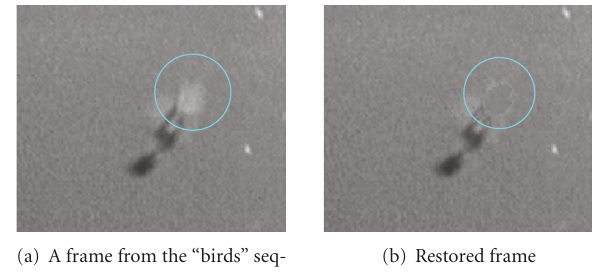
Figure 18: This figure shows an example from the “birds” sequence where the proposed algorithm fails to prevent damage to image data (the highlighted regions). In this example, the object (the bird) undergoing PM is also undergoing a translation. This motion causes the algorithm to fail on some frames but not